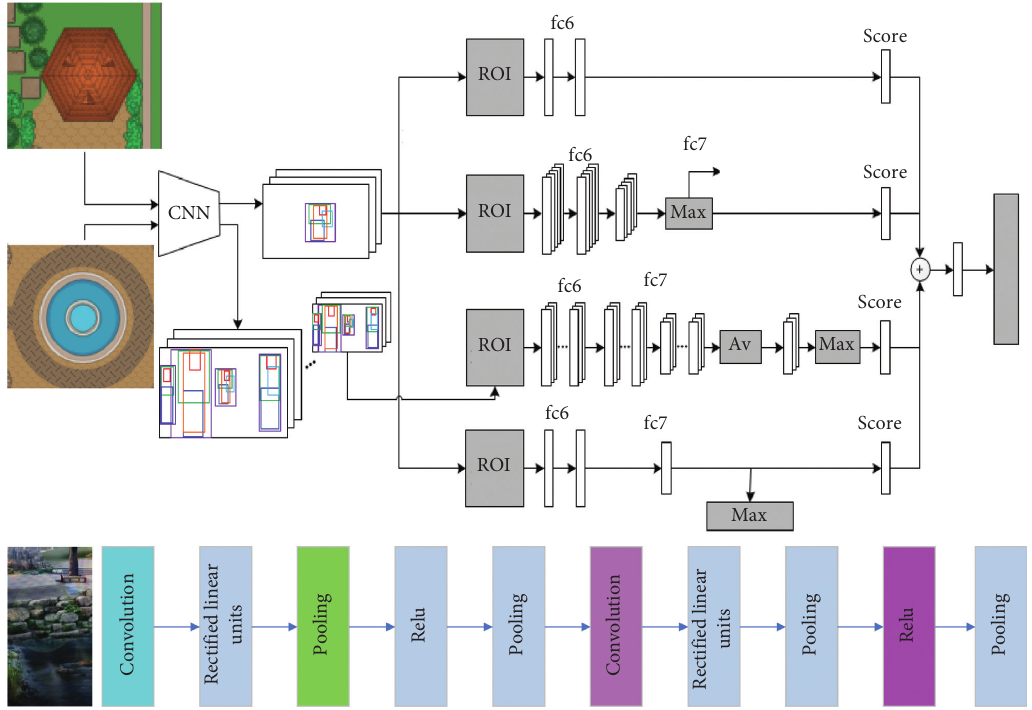
Figure 1: Improved convolutional neural network